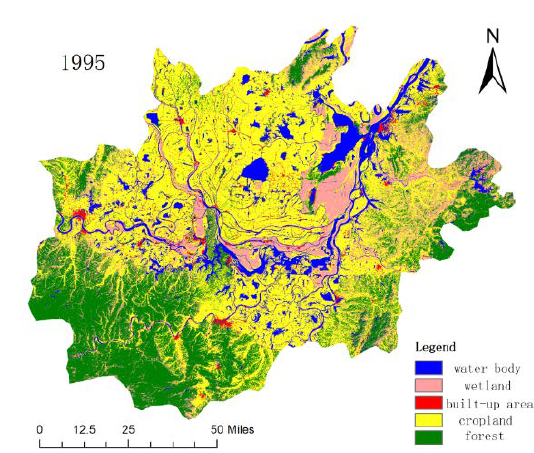
Figure 1. LULC map of Dongting Lake area in 1995